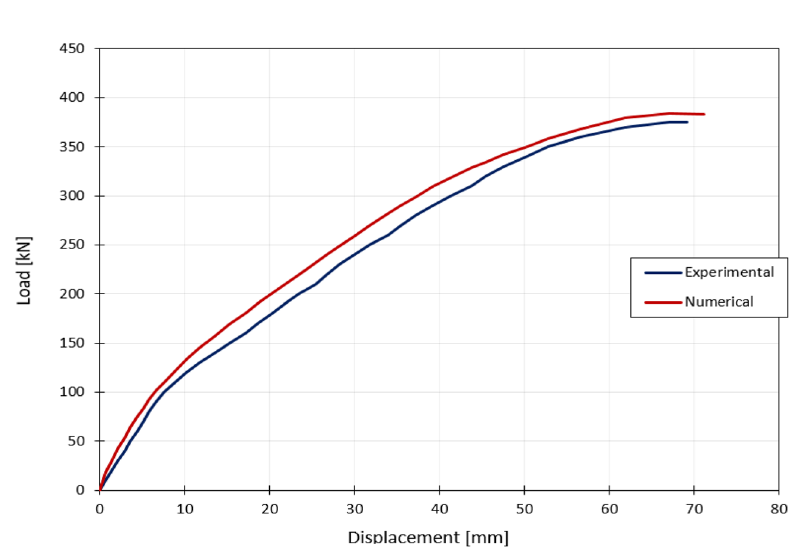
Figure 11. Load–displacement